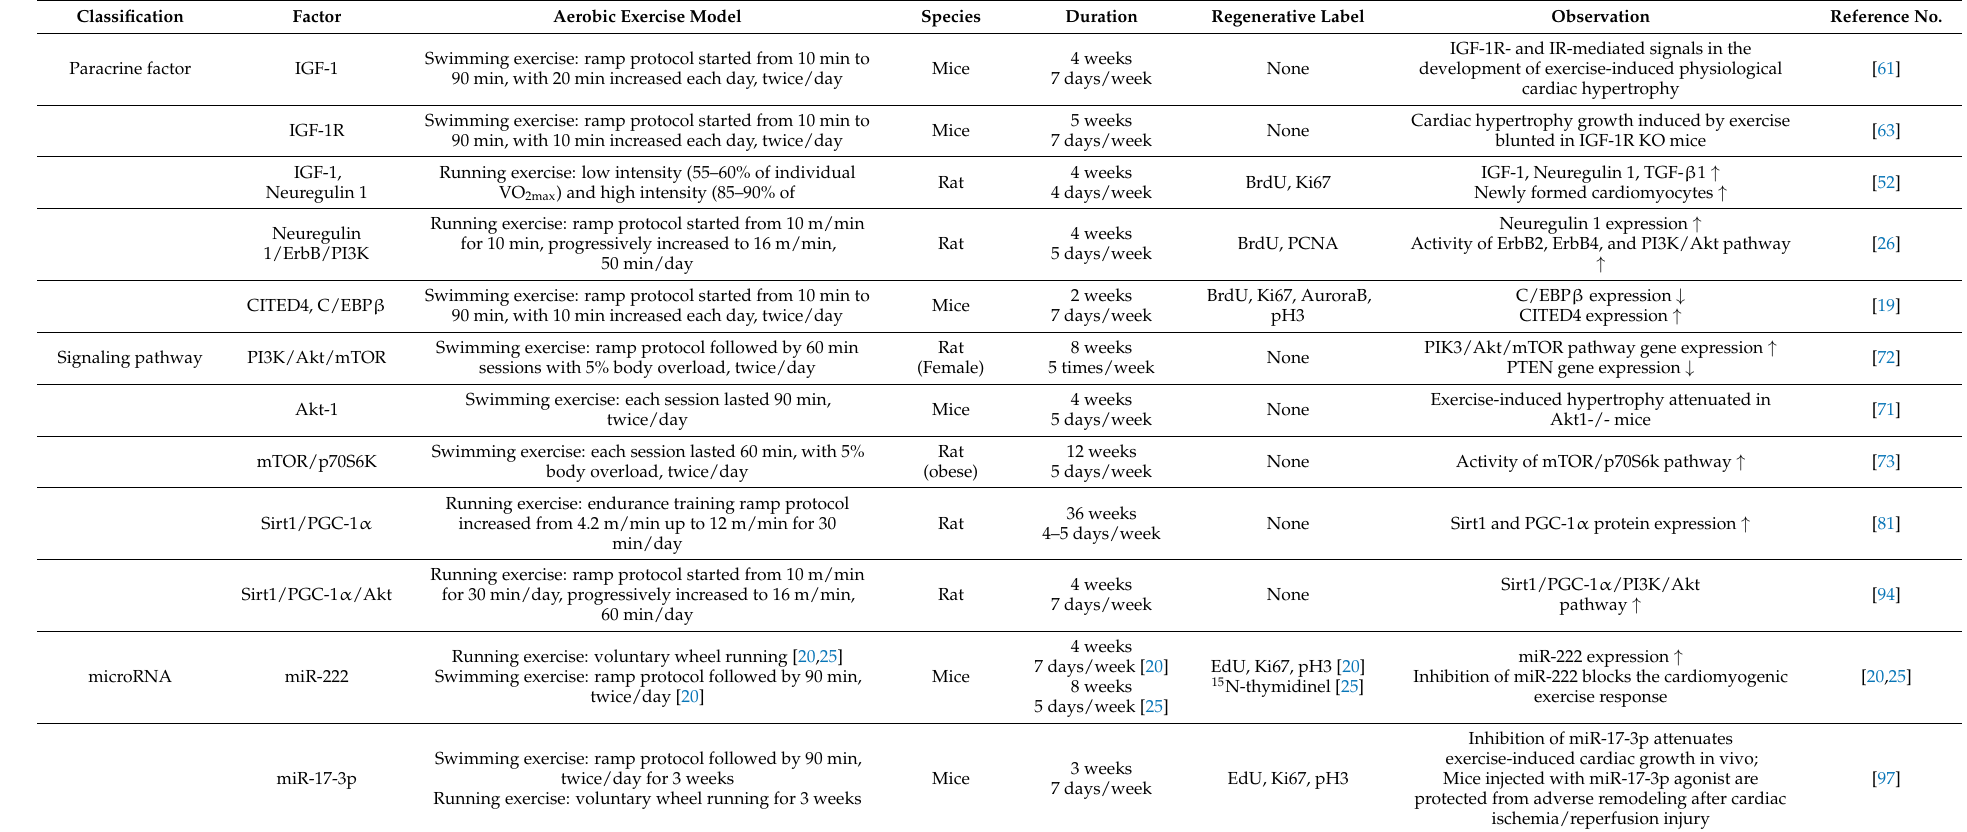
Table 1. Factors related to aerobic exercise-induced cardiac